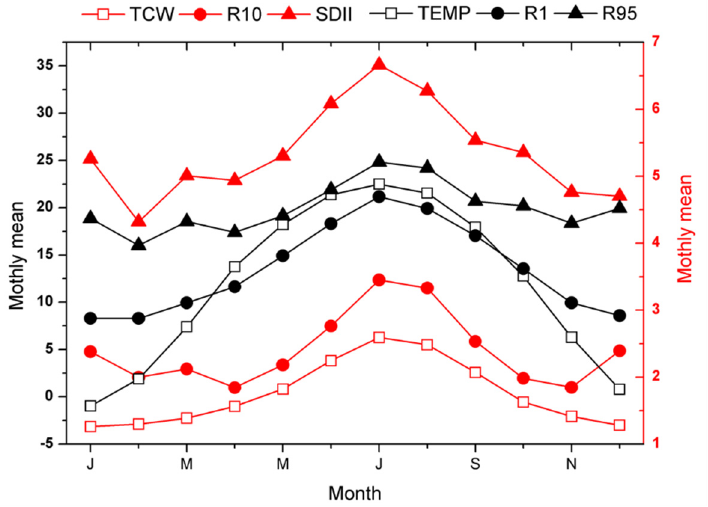
Figure 6. Monthly variation in precipitation climate change indices, surface temperature (T °C), and total column water vapor (TCW g/KG). The black/red colored time series referred to the left/right Y-axis scales.